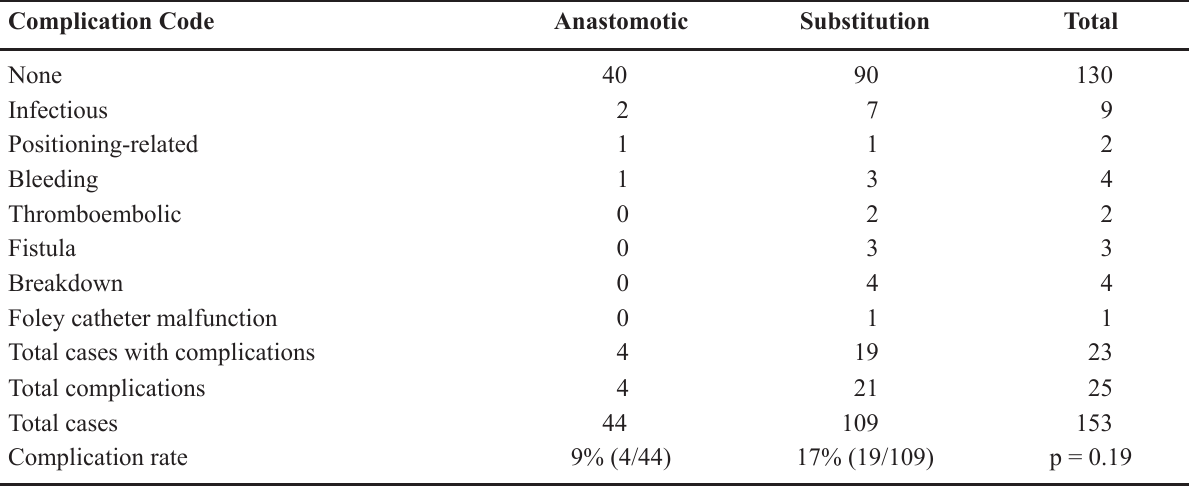
Table 3 – Types of complications for anastomotic and substitution